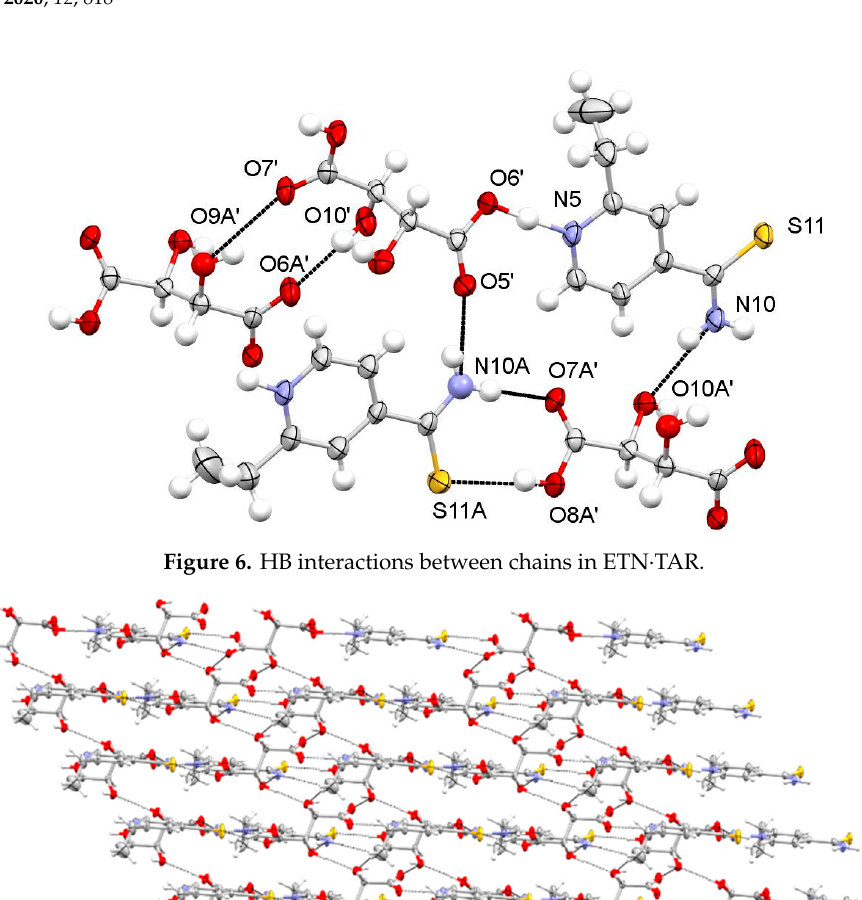
Figure 7. Links between chains through HBs in ETN·TAR.